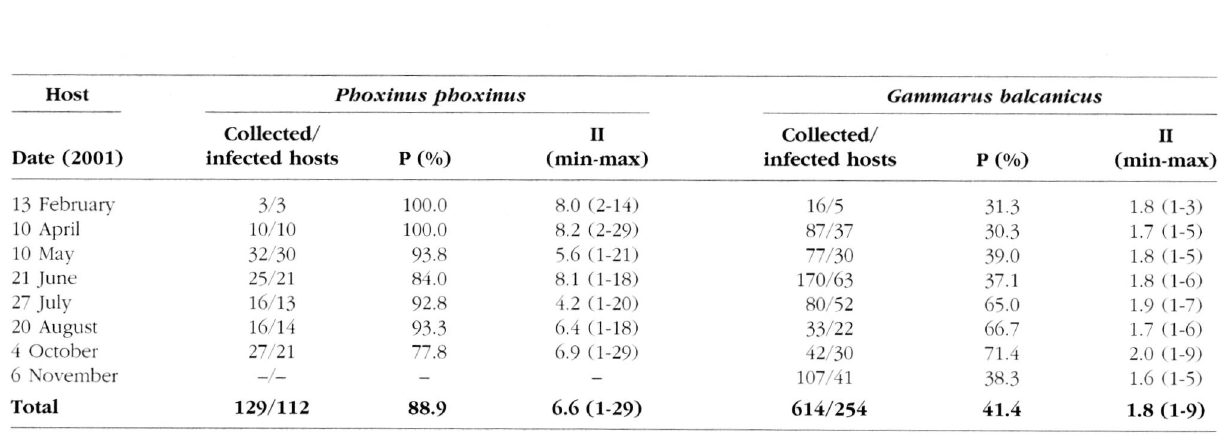
cement glands); and 3) Mature worms with body length exceeding 12 mm (female with shelled acanthors, male with well developed testes and cement glands).